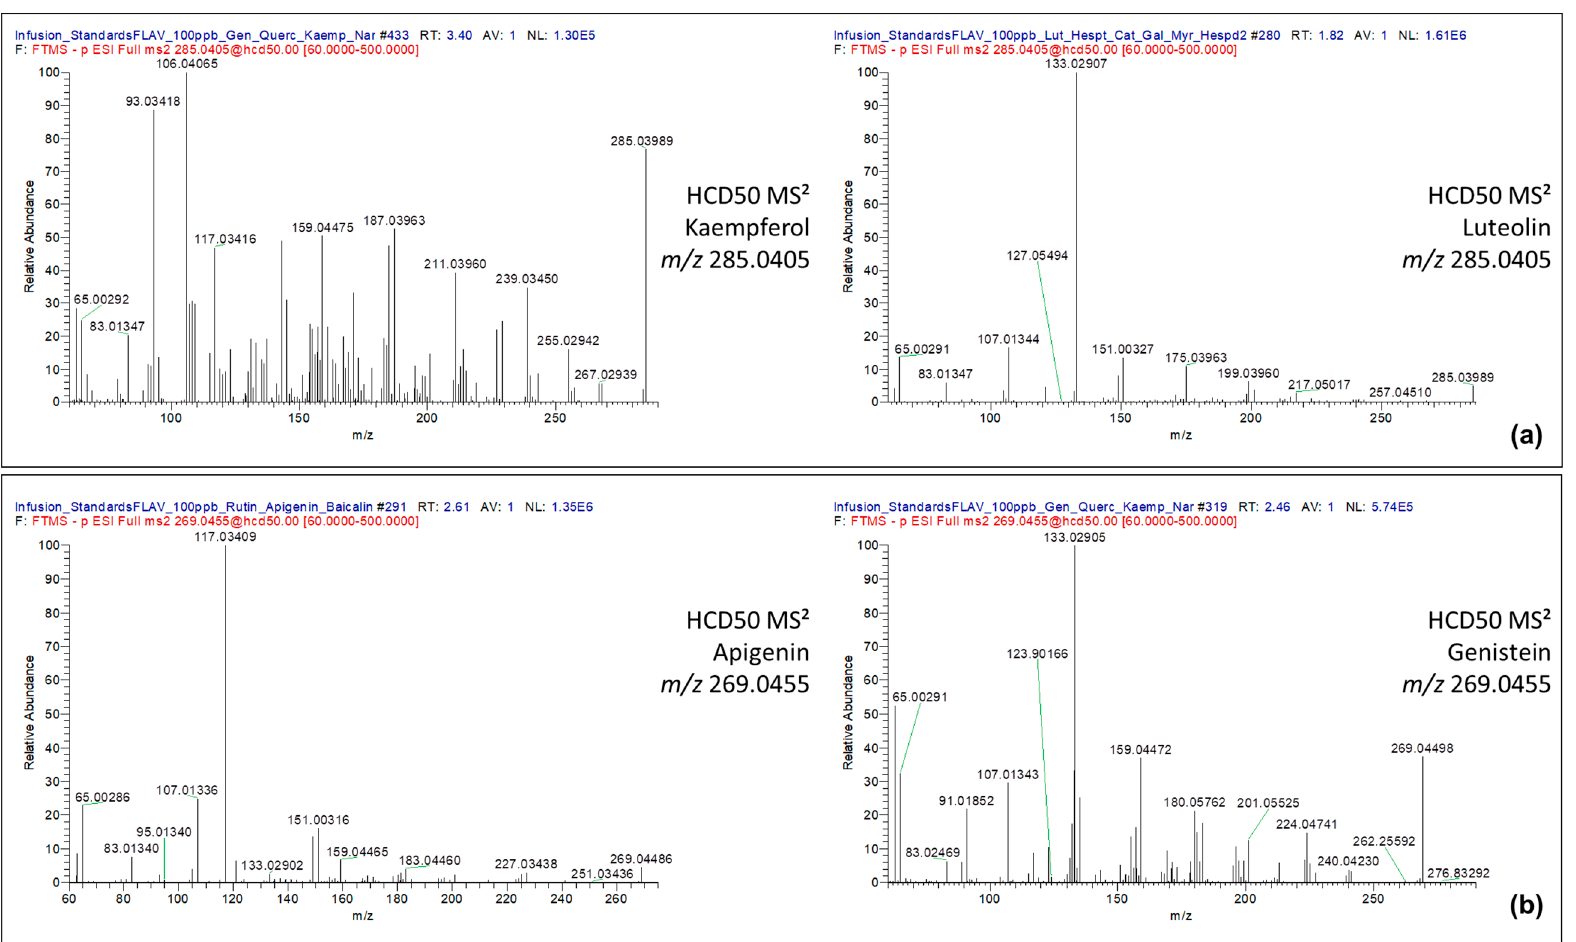
Figure 2. Fragmentation data acquired in HCD50 MS 2 for the isomeric couple kaempferol/luteolin and apigenin/genistein. ( a ) Kaempferol m/z 285.0405 and Lutelin m/z 285.0405; ( b ) Apigenin m/z 269.0455 and Genistein m/z 269.0455